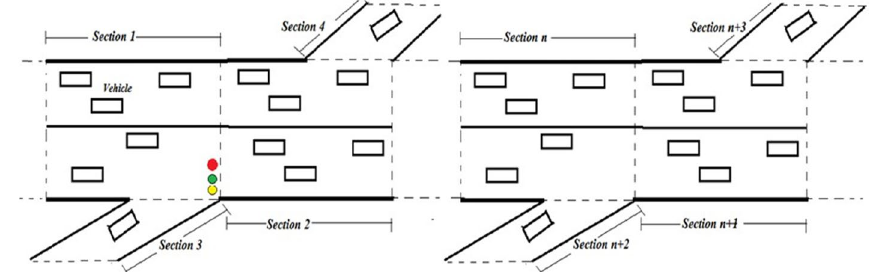
Fig. 1 An example of road traffic data and road